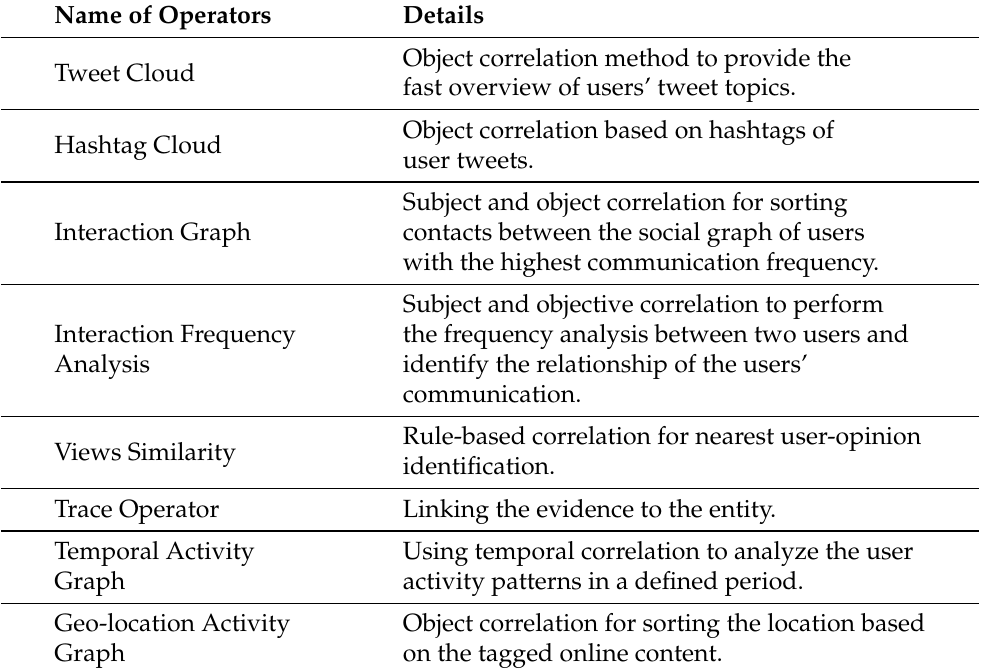
Table 5. Analysis operators list of the following